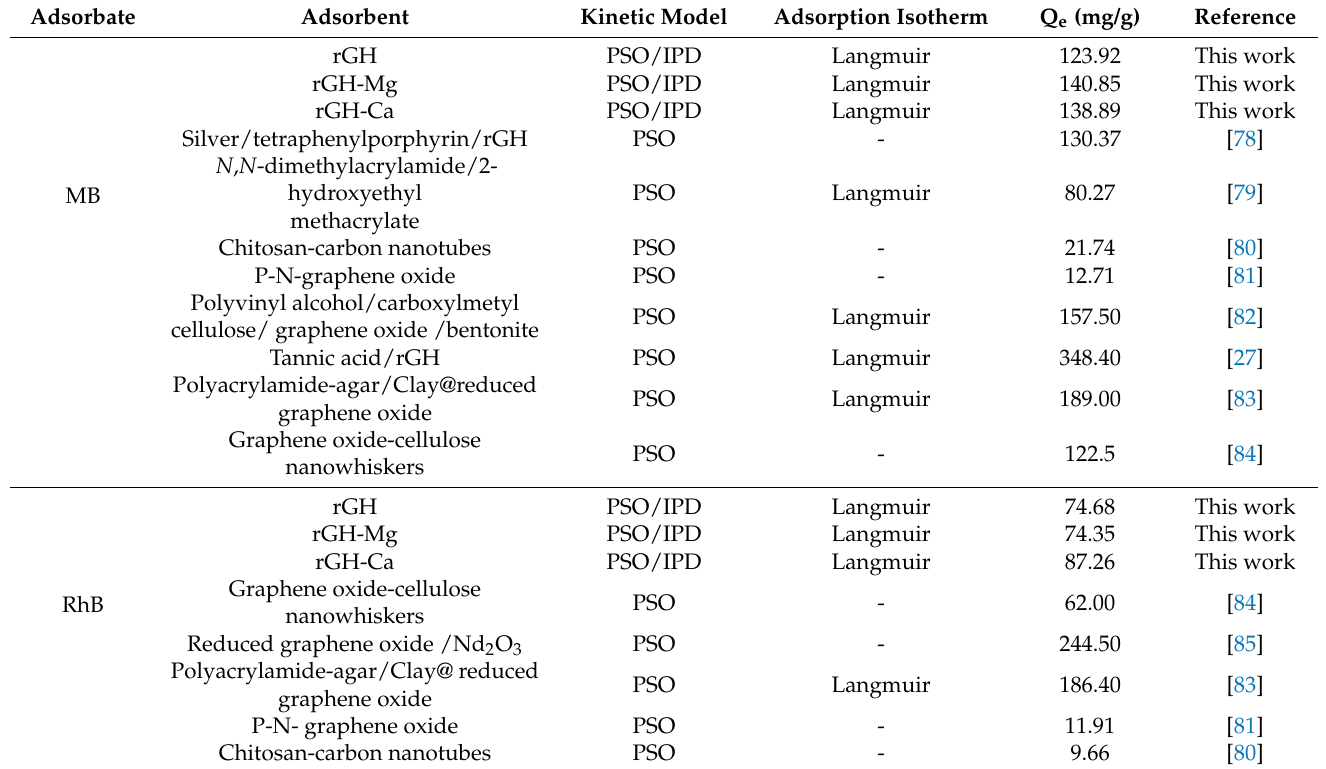
Table 7. Adsorption capacities of MB and RhB onto various hydrogel-based